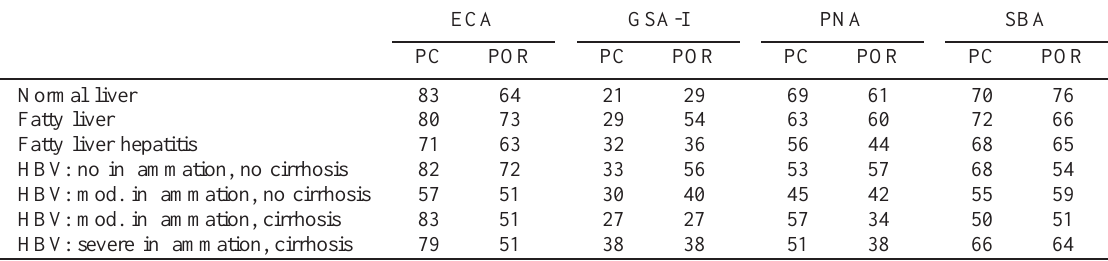
Table 4 Means of numbers of lectin-positive cells expressed as percentage of the mean number of CD68 +